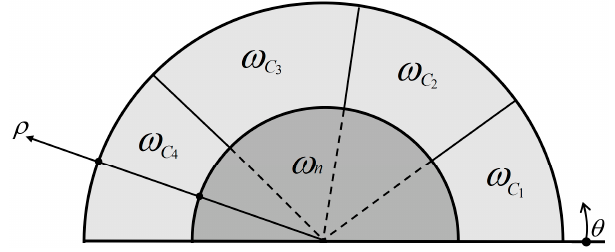
Figure 2 . The 2D compressed polar change representation in S 2 CVA [35]. Figure 2. The 2D compressed polar change representation in S 2 CVA